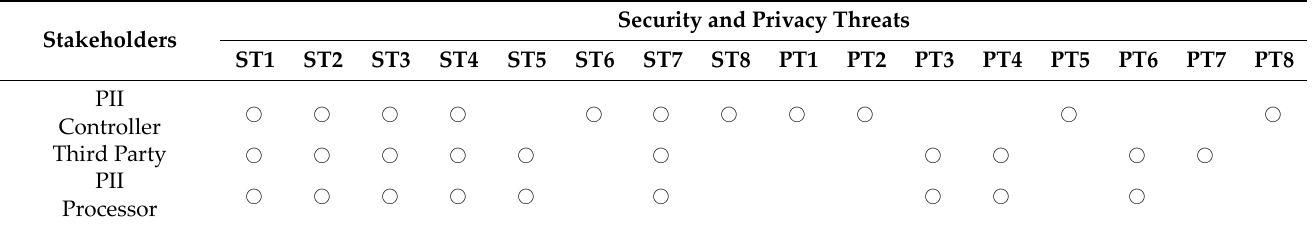
Table 4. Security and privacy threats by